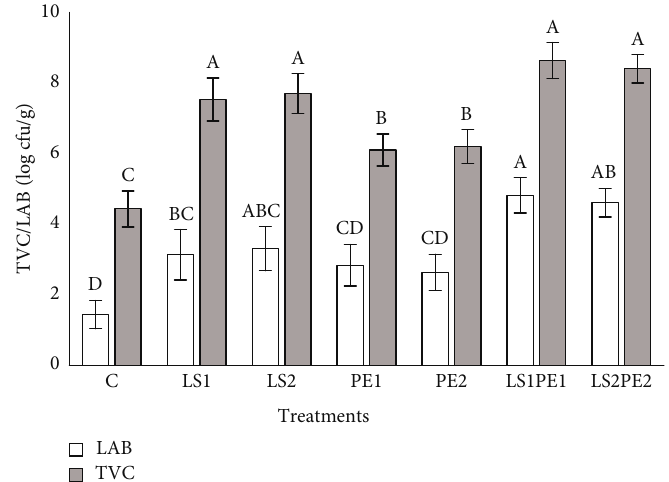
Figure 2: The TVC (total viable heterotrophic bacteria count) and LAB (lactic acid bacteria) of cray fi sh narrow-clawed cray fi sh ( P. leptodactylus ) fed with basal diet and supplemented with LS1 ( L. salivarius , 1 × 10 7 CFU/g), LS2 ( L. salivarius , 1 × 10 9 CFU/g), PE1 (Pectin, 5 g/kg), and PE2 (Pectin, 10 g/kg), LS1PE1 ( L. salivarius , 1 × 10 7 CFU/g +Pectin, 5g/kg) and LS2PE2 ( L. salivarius , 1 × 10 9 CFU/ g+Pectin, 10g/kg) for 18 weeks. Bars represent the mean ± SD ( n = 3 ). Di ff erent superscripts show signi fi cant di ff erences between the experimental groups. Table 3: Hemolymph indices of narrow-clawed cray fi sh ( Postantacus leptodactylus ) fed with basal diet and supplemented with LS1 ( L. salivarius , 1 × 10 7 CFU/g), LS2 ( L. salivarius , 1 × 10 9 CFU/g), PE1 (Pectin, 5 g/kg), and PE2 (Pectin, 10g/kg), LS1PE1 ( L. salivarius , 1 × Treatments